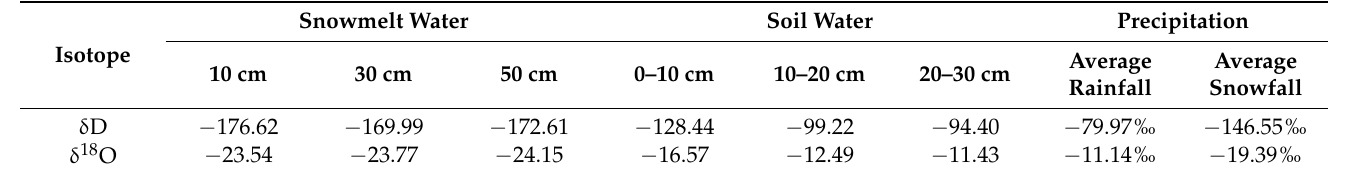
Table 2. The characteristics of the isotopes of the different types of water before the snow melted (‰). Snowmelt Water Isotope